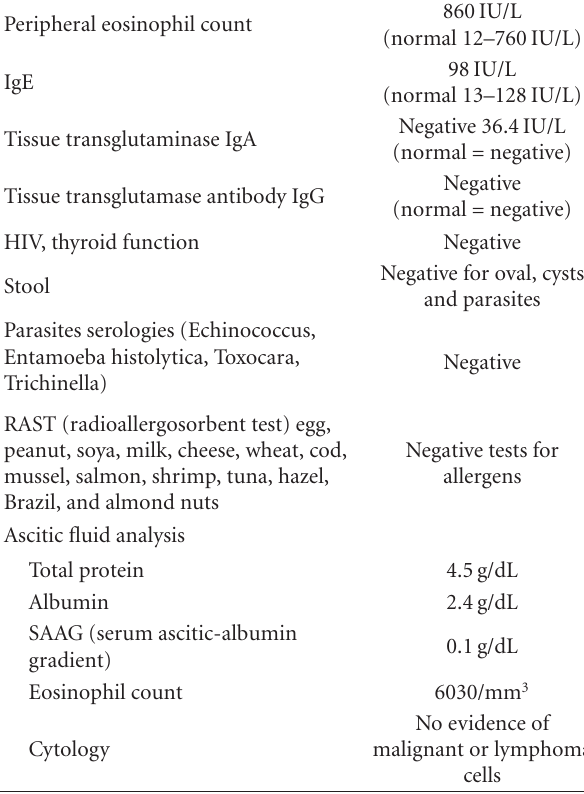
Table 1: Summary of laboratory results.